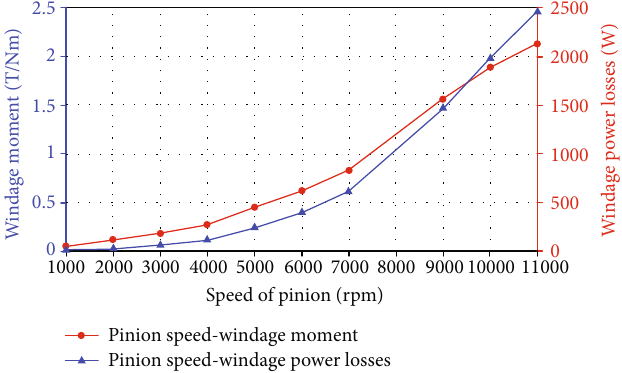
Figure 11: Windage moment and power loss at di ff erent speed of